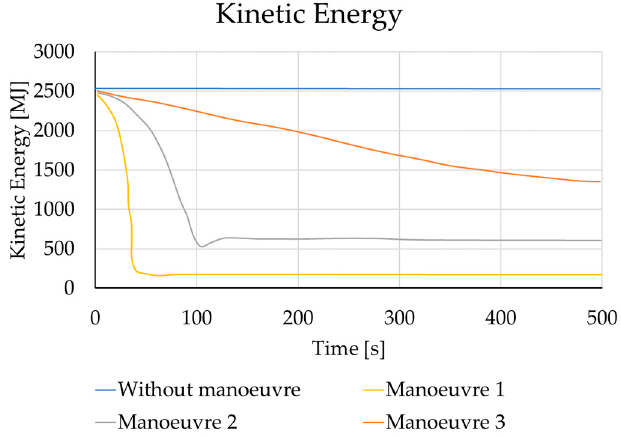
Figure 14. Kinetic energy over